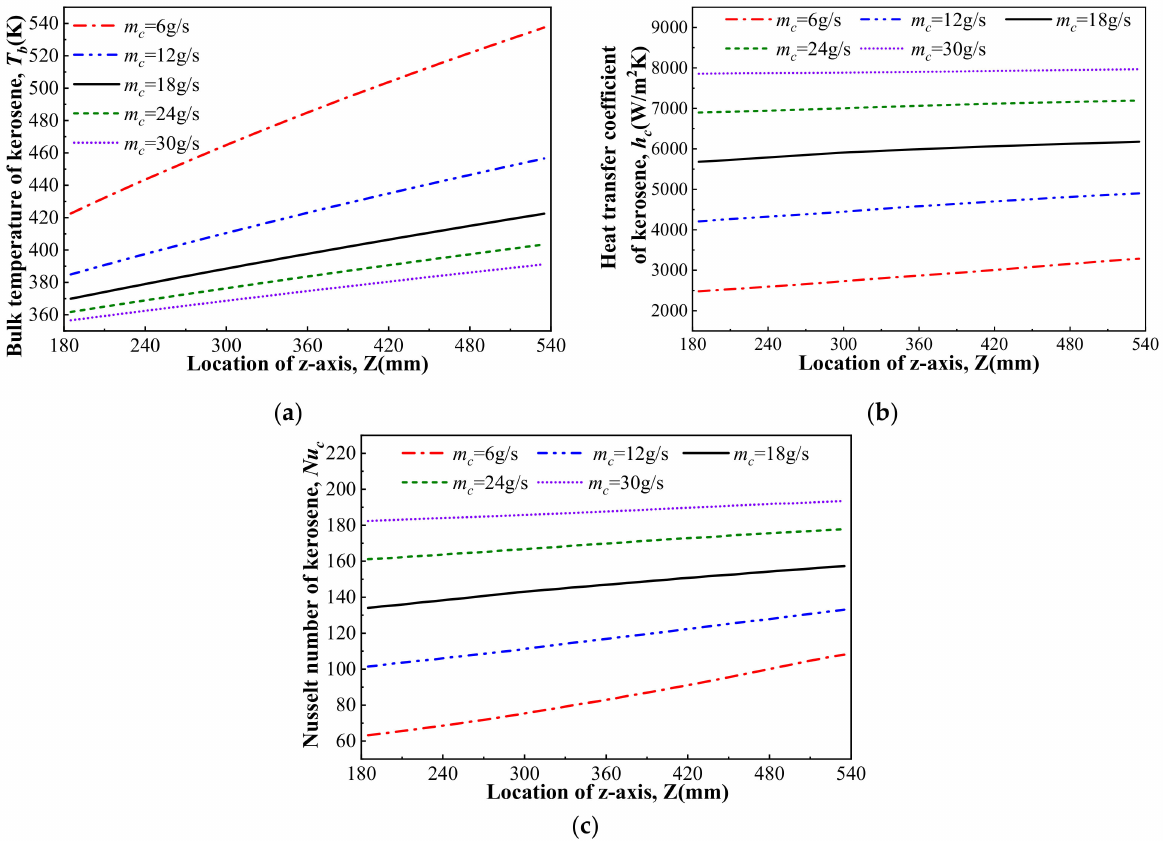
Figure 21. Variation of T b , h c and Nu c with mass flow rate of kerosene: ( a ) T b ( b ) h c ( c ) Nu c